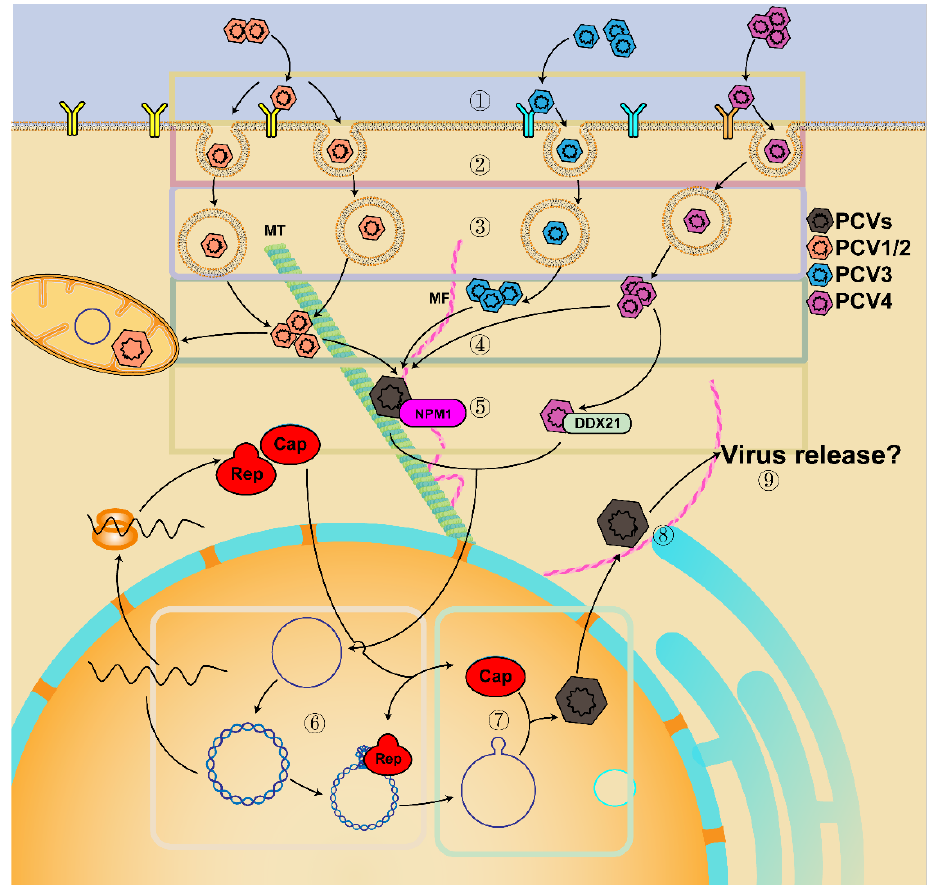
Figure 2. Model of PCV lifecycle. 1 (cid:13) PCV attaches to HS and/or other receptors; 2 (cid:13) PCV enters cells via clathrin-mediated endocytosis, macropinocytosis, or actin and Rho-GTPase dependent manner; 3 (cid:13) PCV is transported in the endosome–lysosome and uncoated by serine protease in a low pH-dependent way or a neutral pH-dependent manner; 4 (cid:13) release from the endosome into the cytoplasm in a low pH-dependent manner; 5 (cid:13) translocation into the nucleus by interacting with tubulin, microtubules (MT), microfiber (MF), NPM1, and DDX21; 6 (cid:13) rolling-circle replication; 7 (cid:13) the newly synthesized Cap is transported into the nucleus for genome encapsidation and assembly in a near-neutral pH; 8 (cid:13) virion transportation to the cytoplasm and shuttle between mitochondria and nucleus; 9 (cid:13) virion